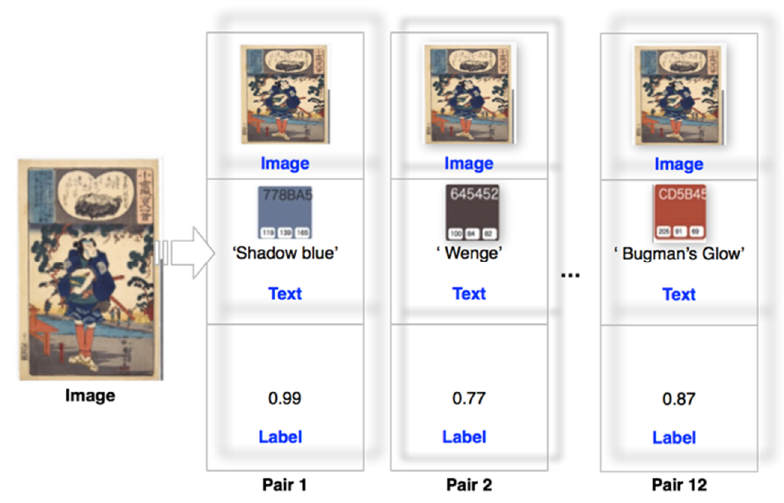
Figure 13. Example of training data of the cross-modal fine-tuning task.